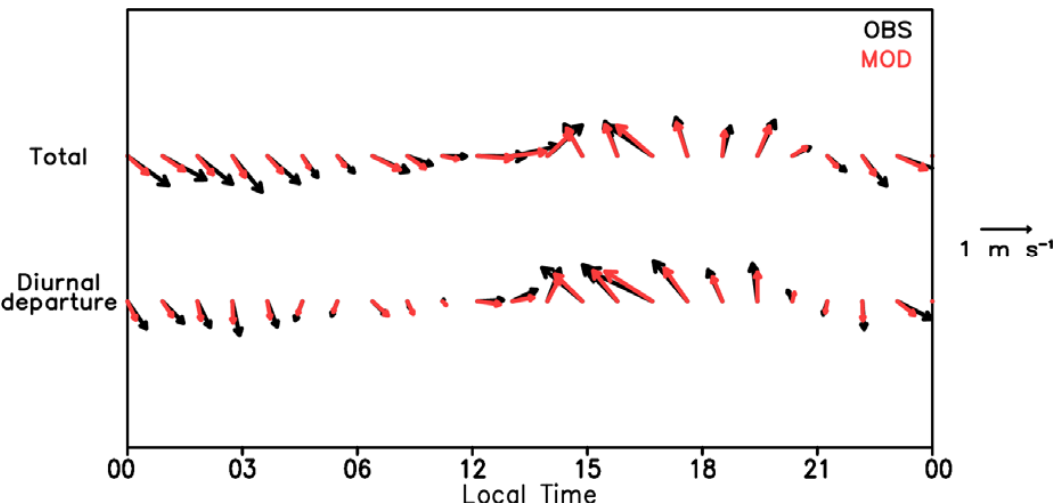
Figure 2. Comparison of local wind vectors (upper) and their diurnal departures from the daily average (lower) obtained from the ASOS observations (black) and the CALMET simulations (red) at the Ulsan station indicated in the open red triangle in Figure 1. The model simulation is the average of the nearest four grid points to the observation station. The hourly wind vectors are the monthly averages each hour for August 2013. The unit is m s − 1 .